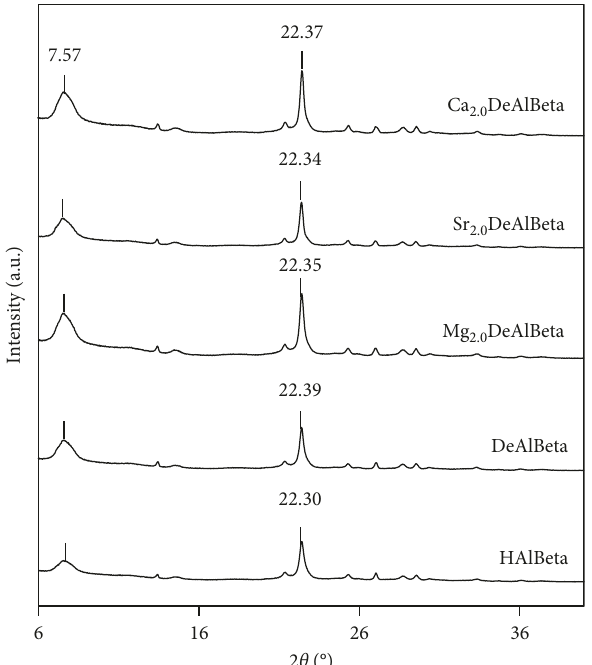
Figure 3: XRD patterns of HAlBeta, DeAlBeta, Mg 2.0 DeAlBeta, Sr 2.0 DeAlBeta, and Ca 2.0 DeAlBeta